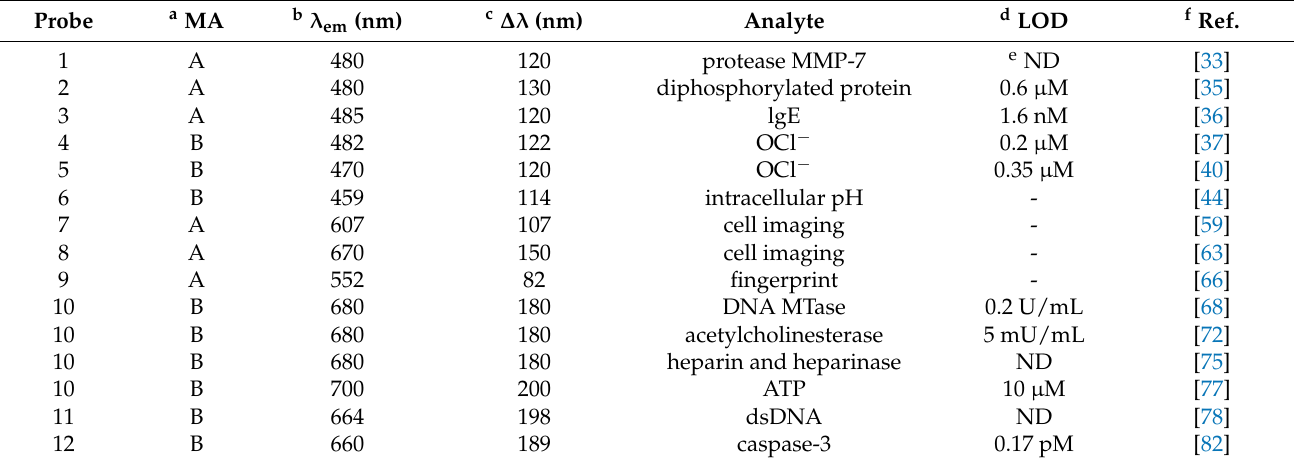
Table 1. Highlights of fluorescent probes included in this review for biological